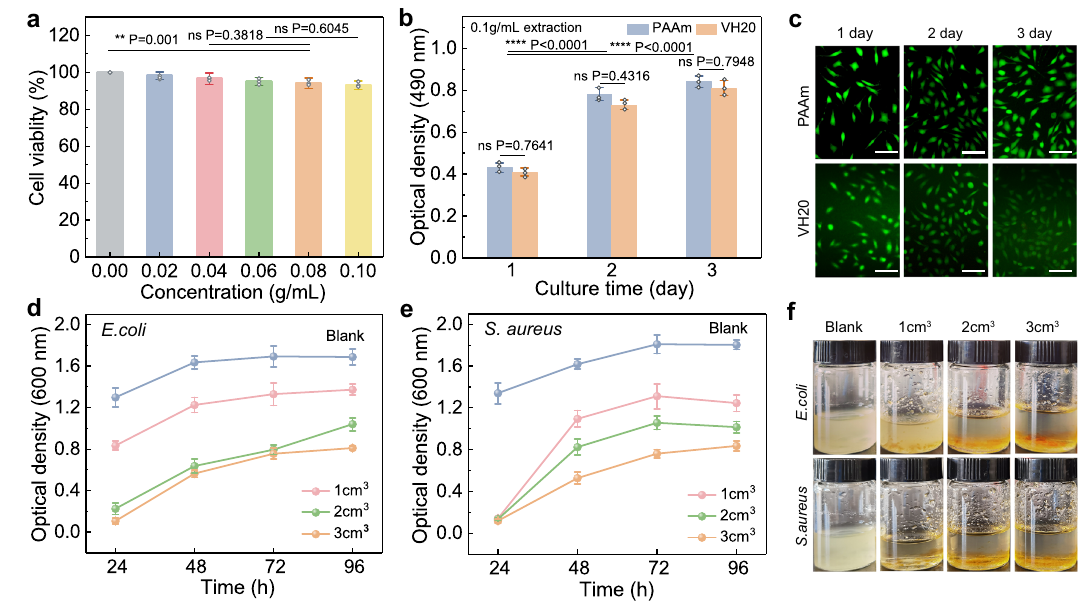
Fig. 2 | Cytocompatibility and antibacterial properties of P(AM-co-SV) hydro- gels. a Cell viability of L929 cultured with various dosages of VH20 hydrogel extracts. ( n = 3 independent experiments). b L929 cell proliferation cultured with 0.1gmL − 1 of VH20 hydrogel extracts and PAAm ( n = 3 independent experiments). c FluorescencemicrographsofL929culturedonPAAmandVH20hydrogels. d The optical density of VH20 hydrogels after co-culture with E. coli and ( e ) S. aureus